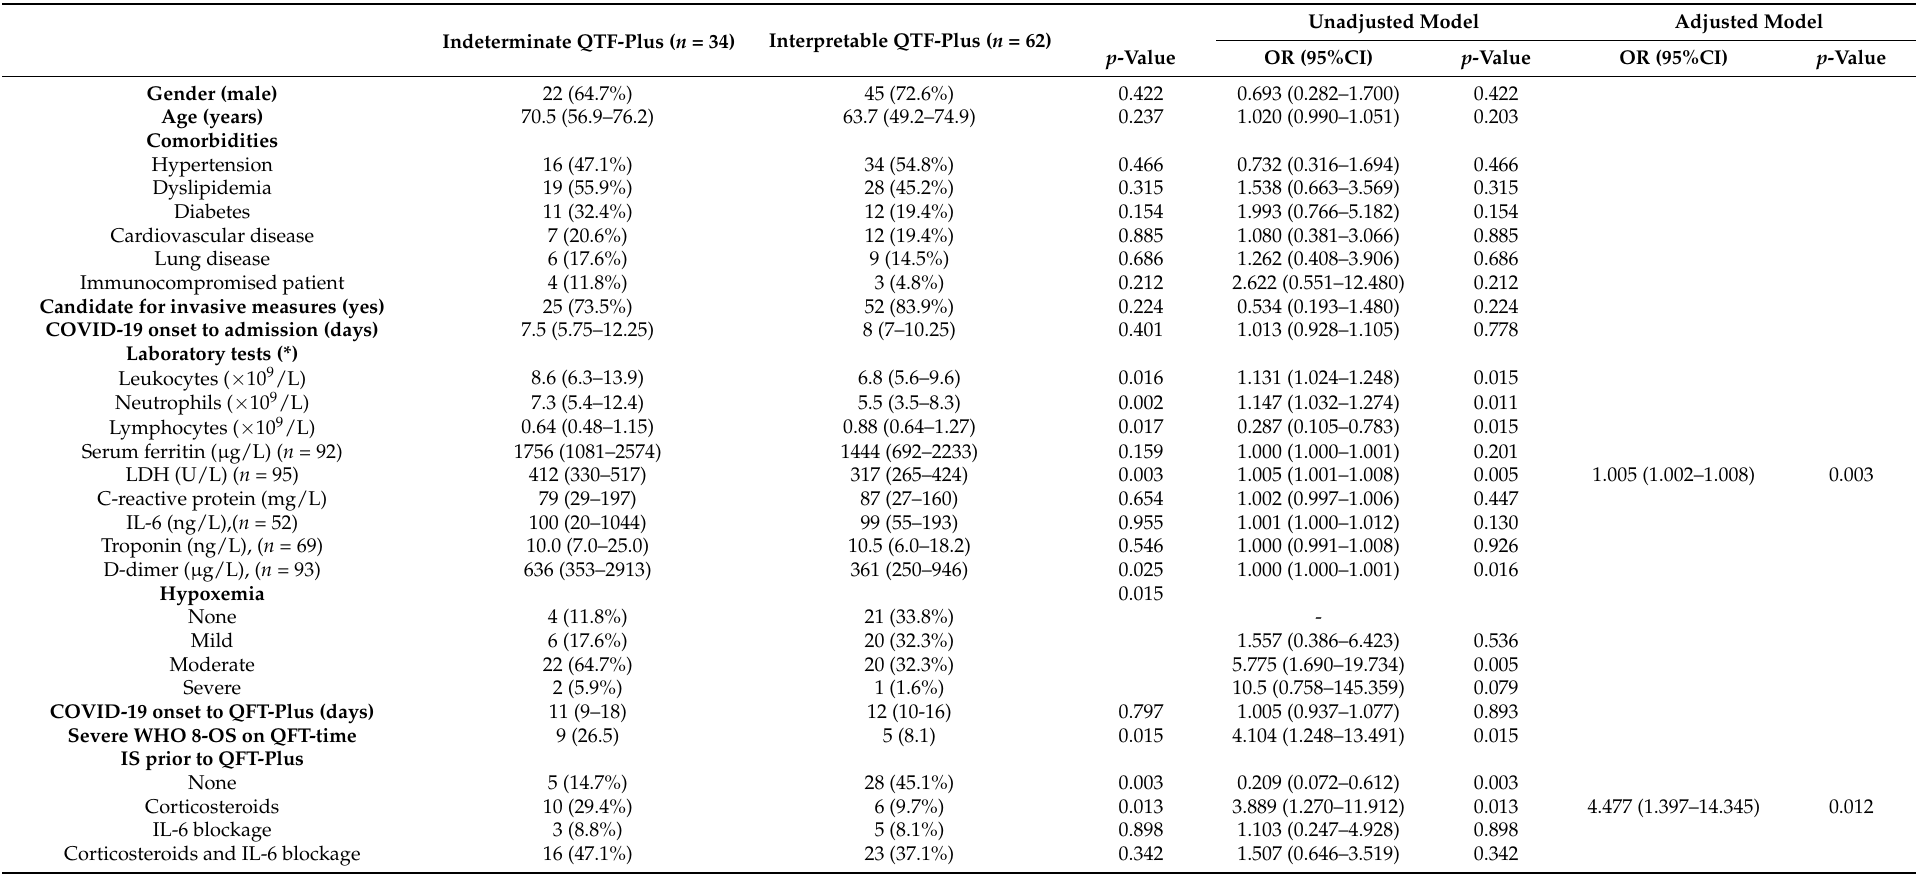
Table 1. Main characteristics of 96 COVID-19 hospitalized patients according the QuantiFERON-TB Gold Plus (QFT-Plus) test